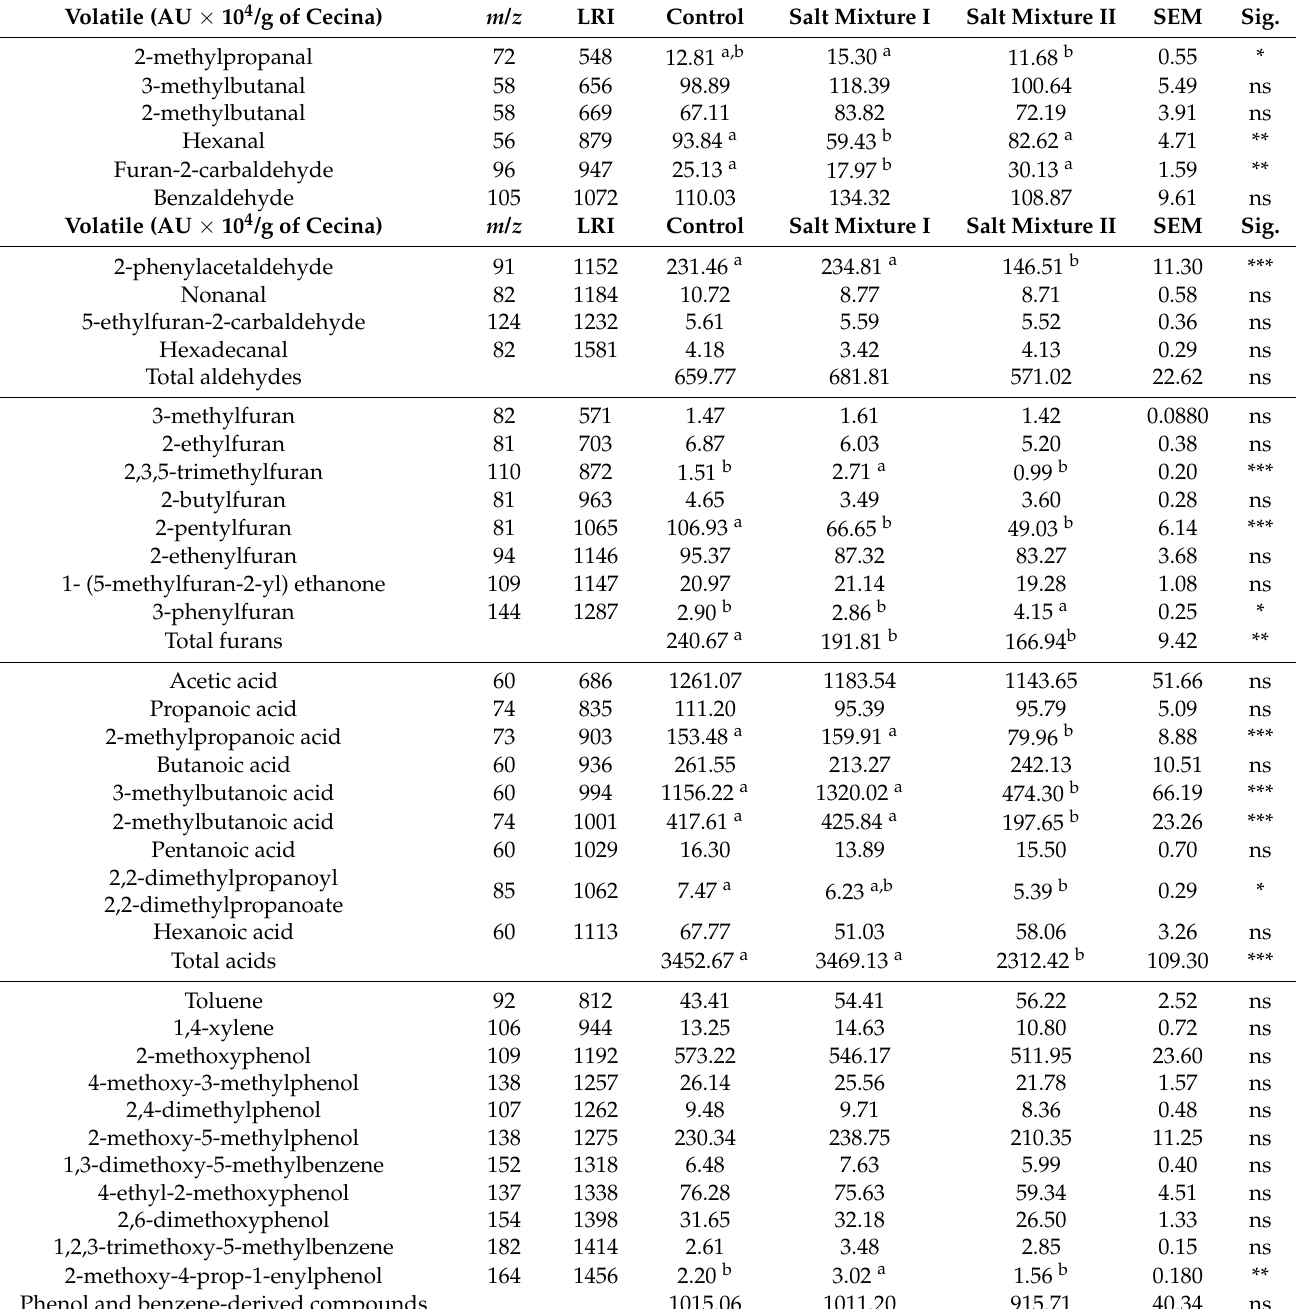
Table 7. Effect of NaCl replacement by other chloride salts on aldehyde, furans, acids, phenol and benzene-derived compounds, others and total volatile compounds content of dry-cured deer “cecina”. Volatile (AU × 10 4 /g of